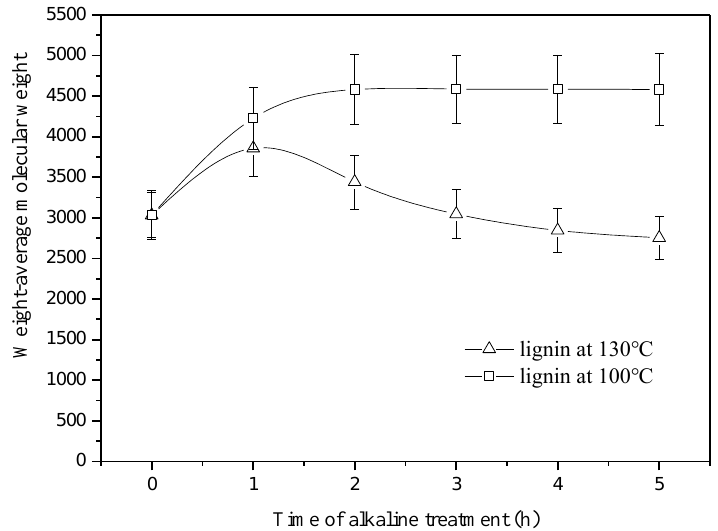
Figure 2. Weight-average molecular weight of residual lignin in the jute fibers pretreated at 100 and 130 °C.